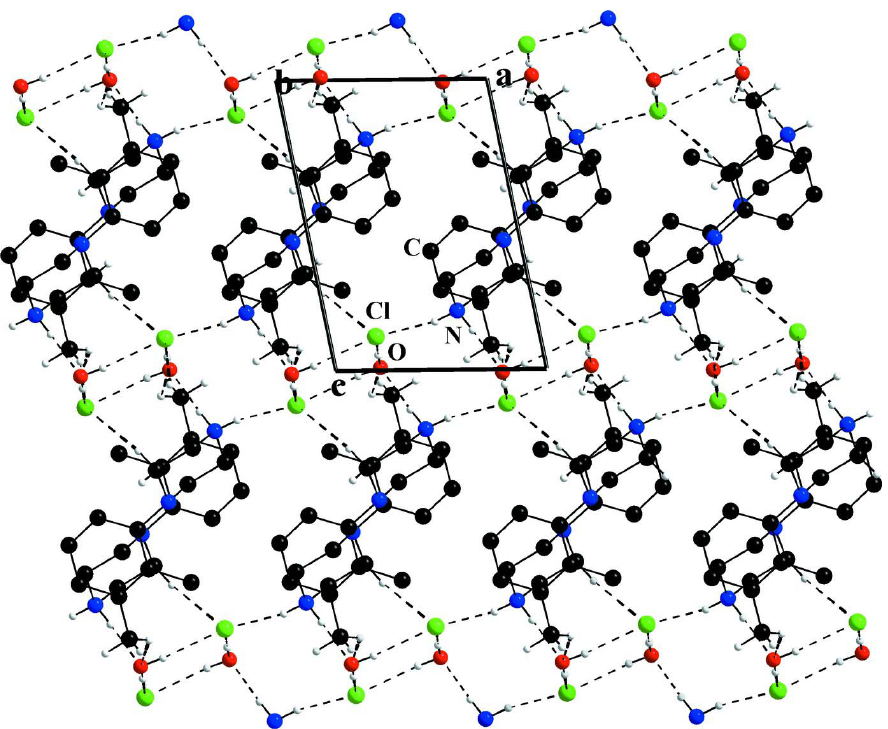
The packing of (I), viewed down the b axis, showing the zigzag character of the structure. Hydrogen bonds are indicated by dashed